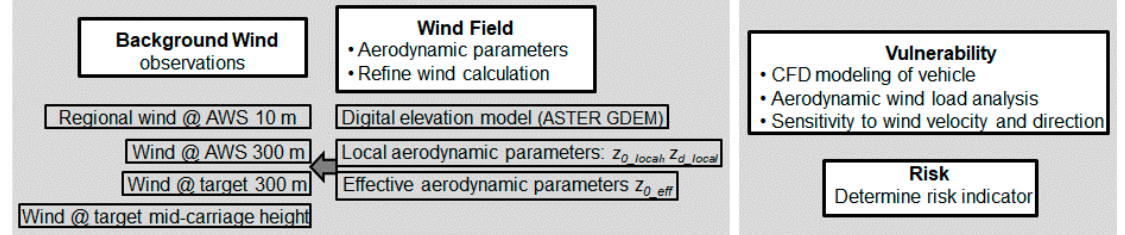
Figure 3. Steps to evaluate rail transport safety within the wind risk warning model for rail transport